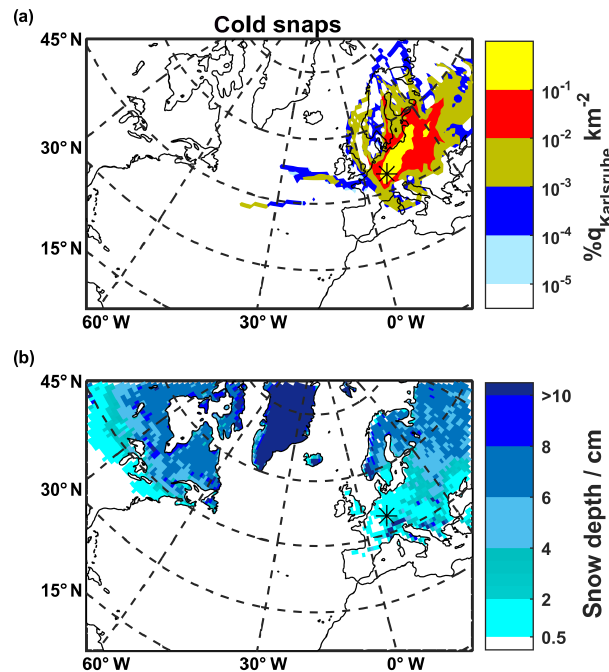
Figure 8. (a) Lagrangian source region analysis of low-level water vapor in Karlsruhe for the observed cold snaps. The mean identi- fied fraction of moisture along the 5-day back trajectories is 48%. (b) Mean snow depth during the cold snaps based on GDAS